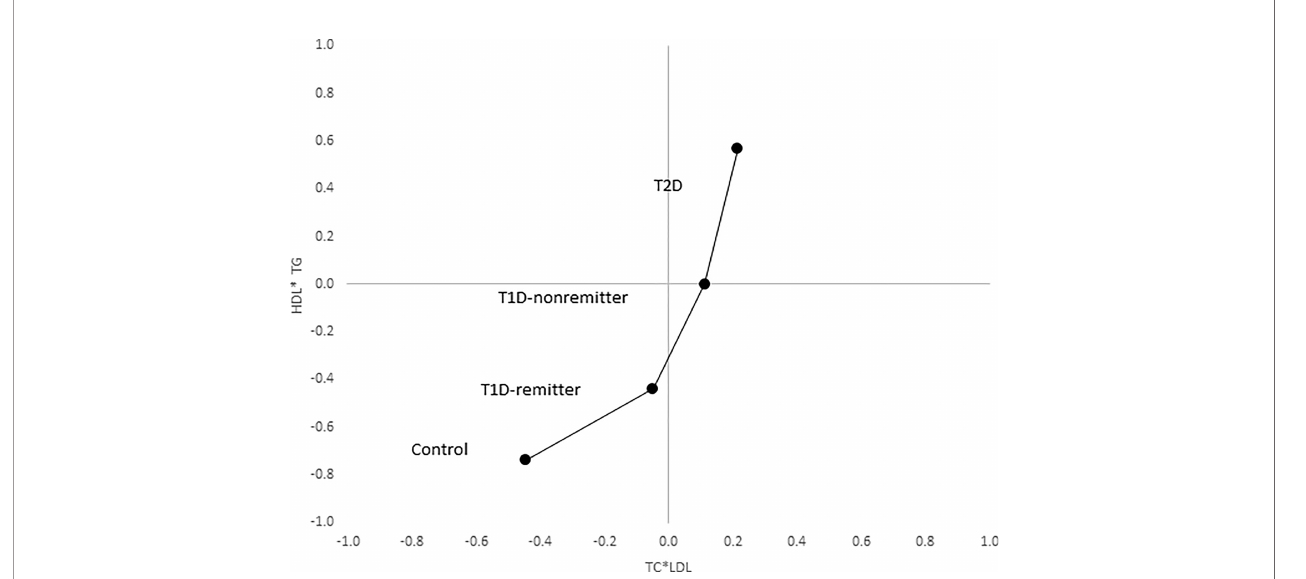
FIGURE 11 | Mean composite score for lipid parameters by factor analysis. Two-dimensional depiction of the mean composite scores of factor 1 (TC*LDL) and factor 2 (HDL*TG) from the factorial analysis of the 7 lipid parameters. Both the controls and remitters are in the low composite risk quadrant, whereas non-remitters and remitters are in the higher risk quadrants. Both factor 1 and factor 2 explained 90% of the variance in the original lipid parameters, p values 0.0042 and <0.0001 respectively. The p-values for linear trends were obtained from linear regression models on composite scores, adjusted for age, sex, ethnicity and BMI